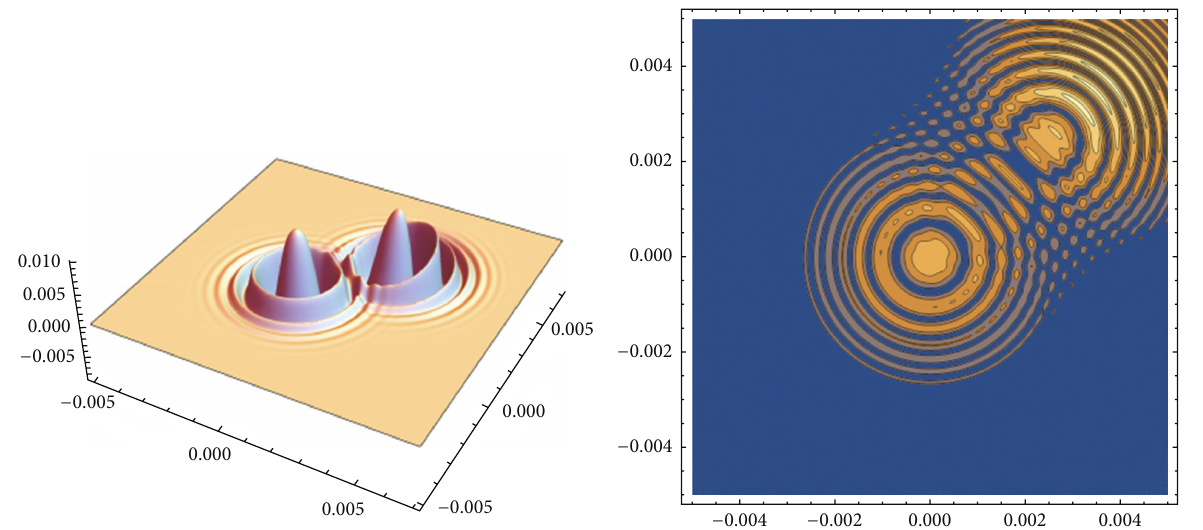
Figure 4: Mapping of the stroboscopic surface thermal lensing in large-scaled radiation